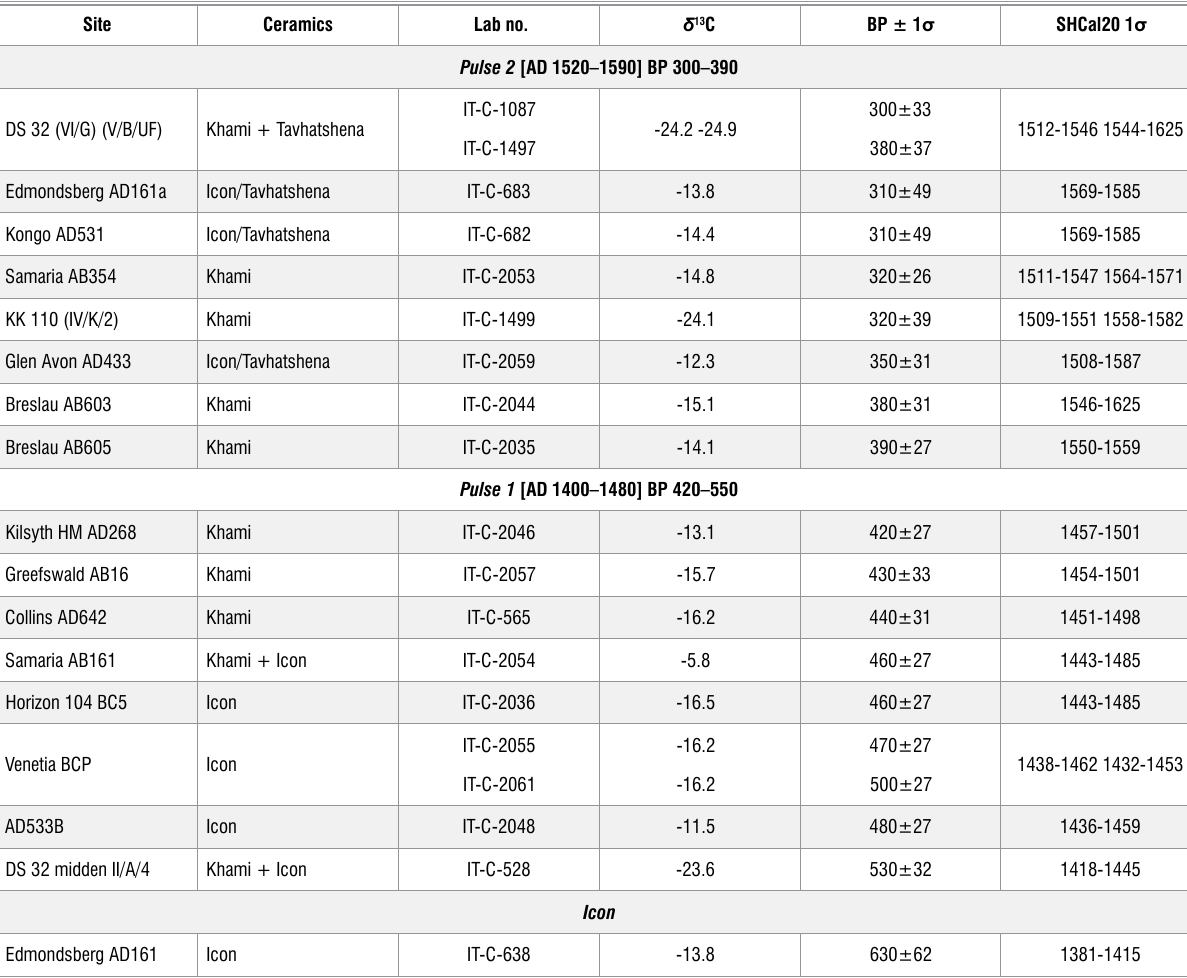
New AMS dates for the Khami Period in the Mapungubwe Landscape: SHCal20 from Calib 8.10